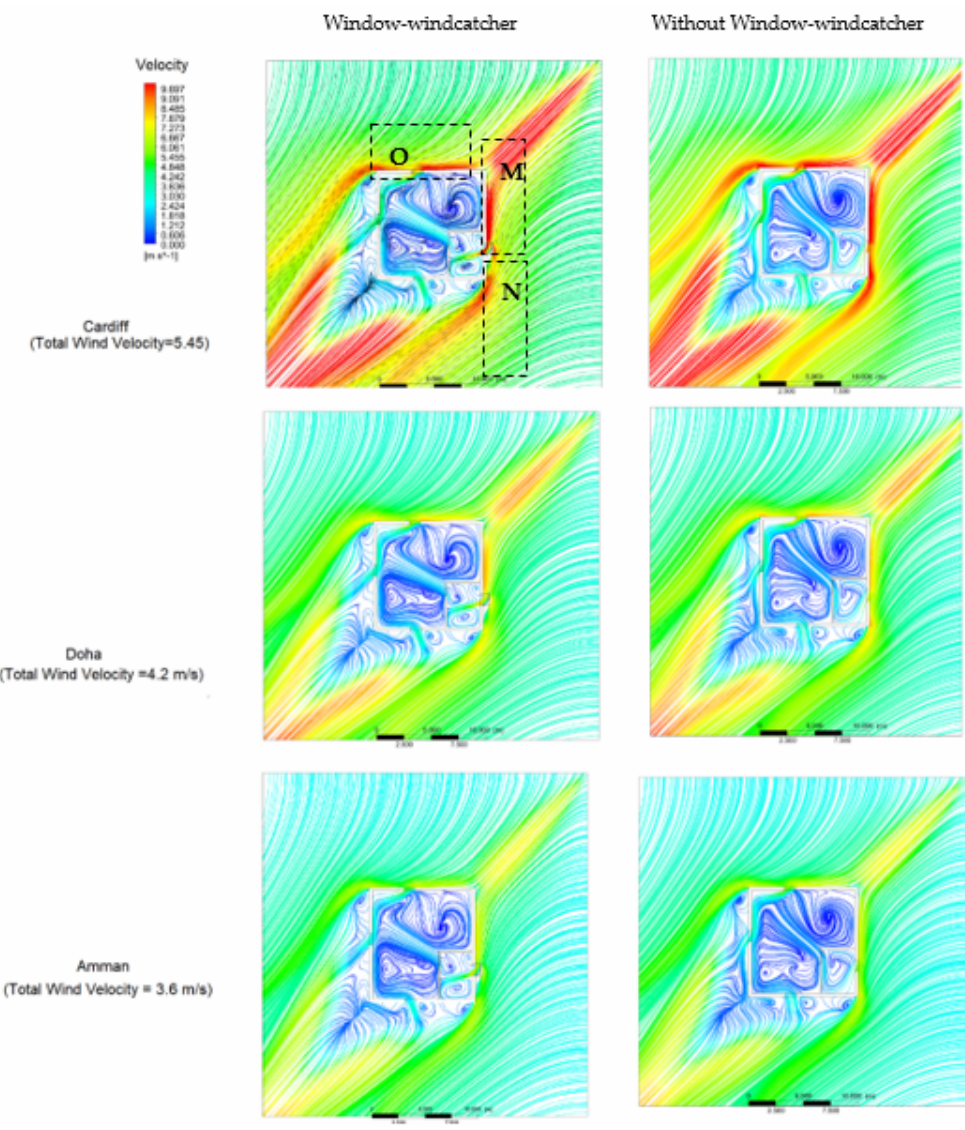
Figure 15. Streamlines at the 1 m plane (internal and external domain) .